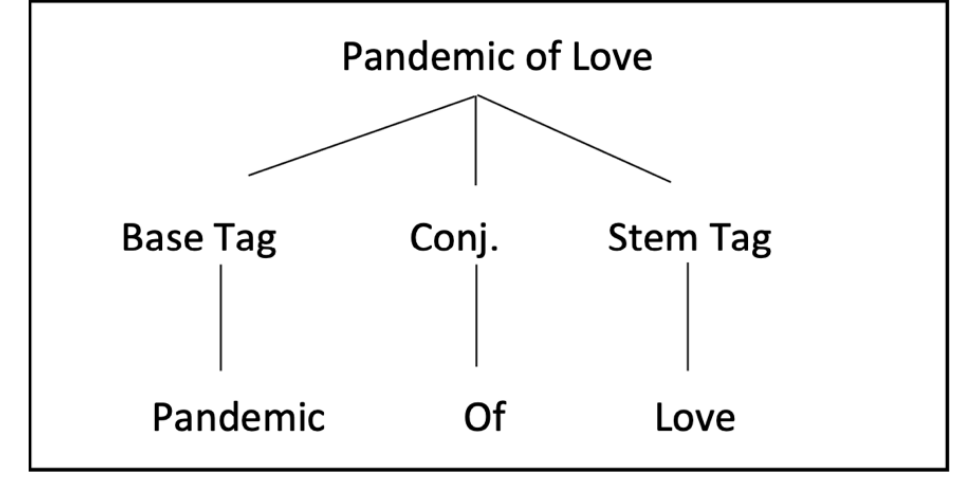
Figure 2. Segmentation of Complex